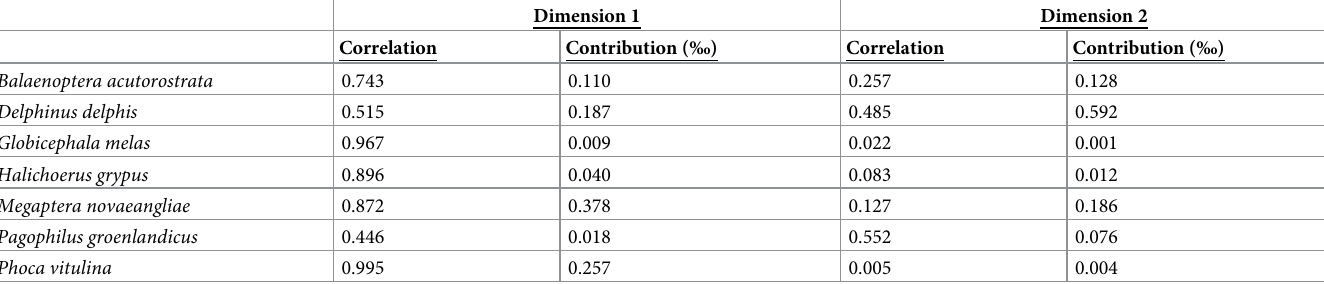
Table 6. Species correlations and contributions to correspondence analysis dimensions 1 and